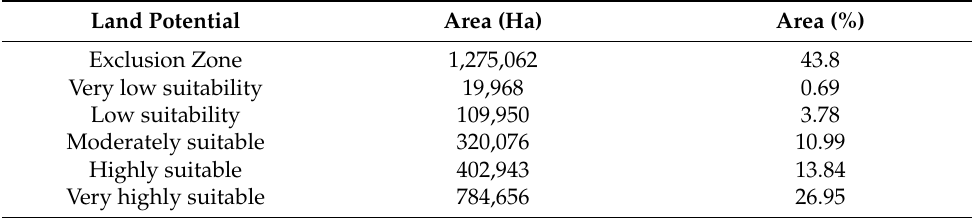
Table 4. Classification of land for aquaculture development in Markazi province.